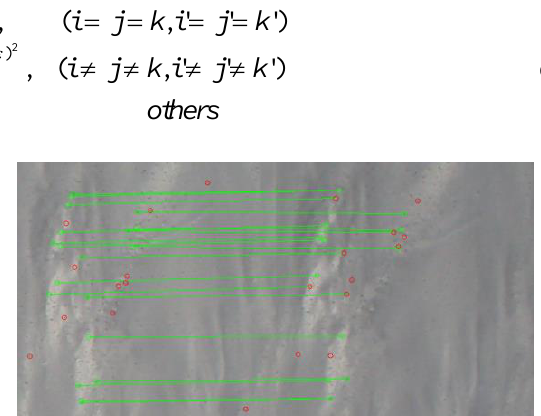
(b) Dessert aerial image matching result